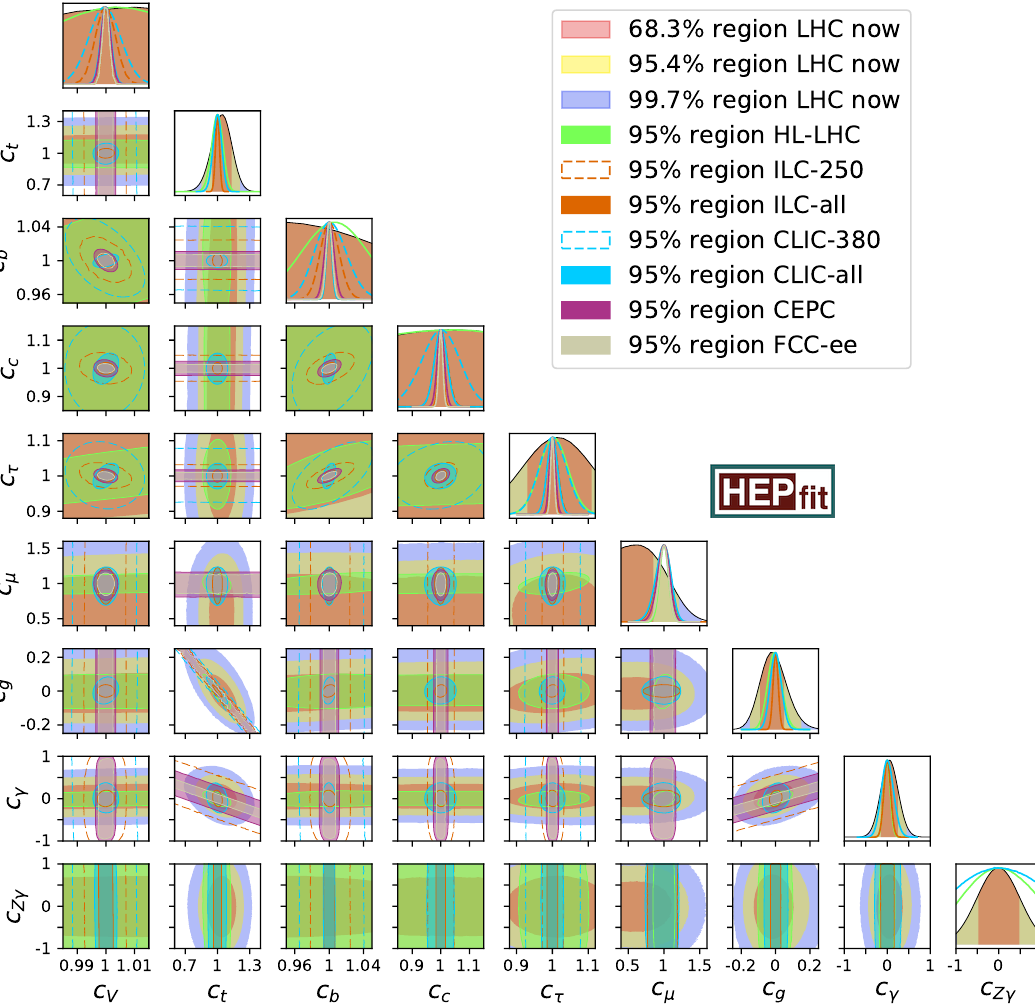
Figure 6 . On top of the (cid:12)t to current data in the background (same as in (cid:12)gure 5) we illustrate the presumed impact of future colliders on the parameters c i with i = V; t; b; c; (cid:28); (cid:22); g; (cid:13); Z(cid:13) . For the future projections, we only show the 95% probability regions; for the corresponding colours we refer to the legend and to table 4. (Note that, while current results for c c and c Z(cid:13) are obtained using the priors P EFT , we use (cid:13)at priors for the calculation of future